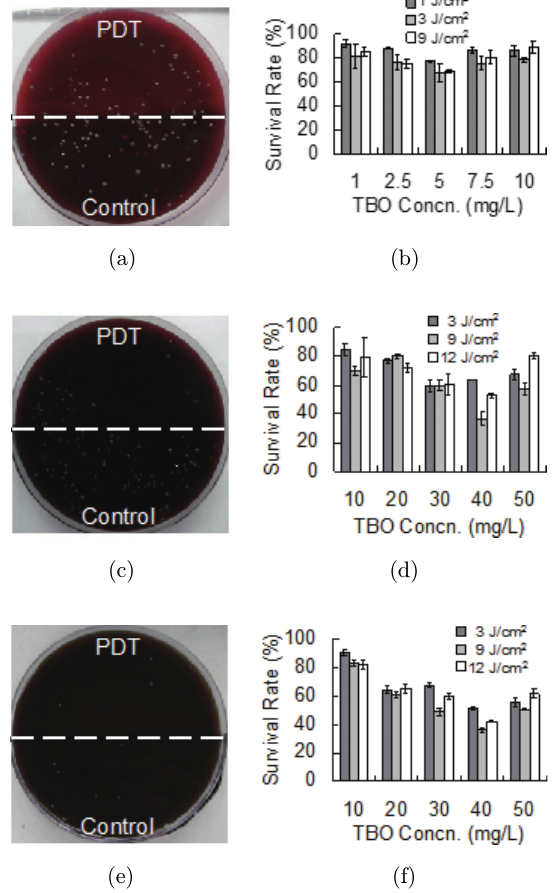
Fig. 2. Exogenous PDT (with red light and TBO as photo- sensitizer) e®ects on three pathogenic bacteria of